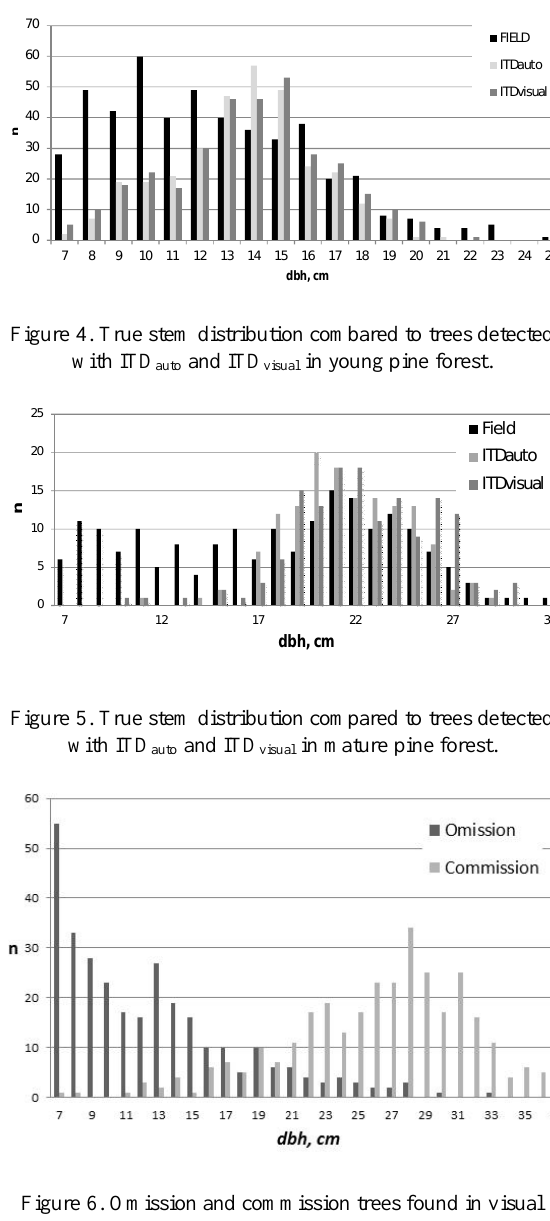
Figure 6. Omission and commission trees found in visual